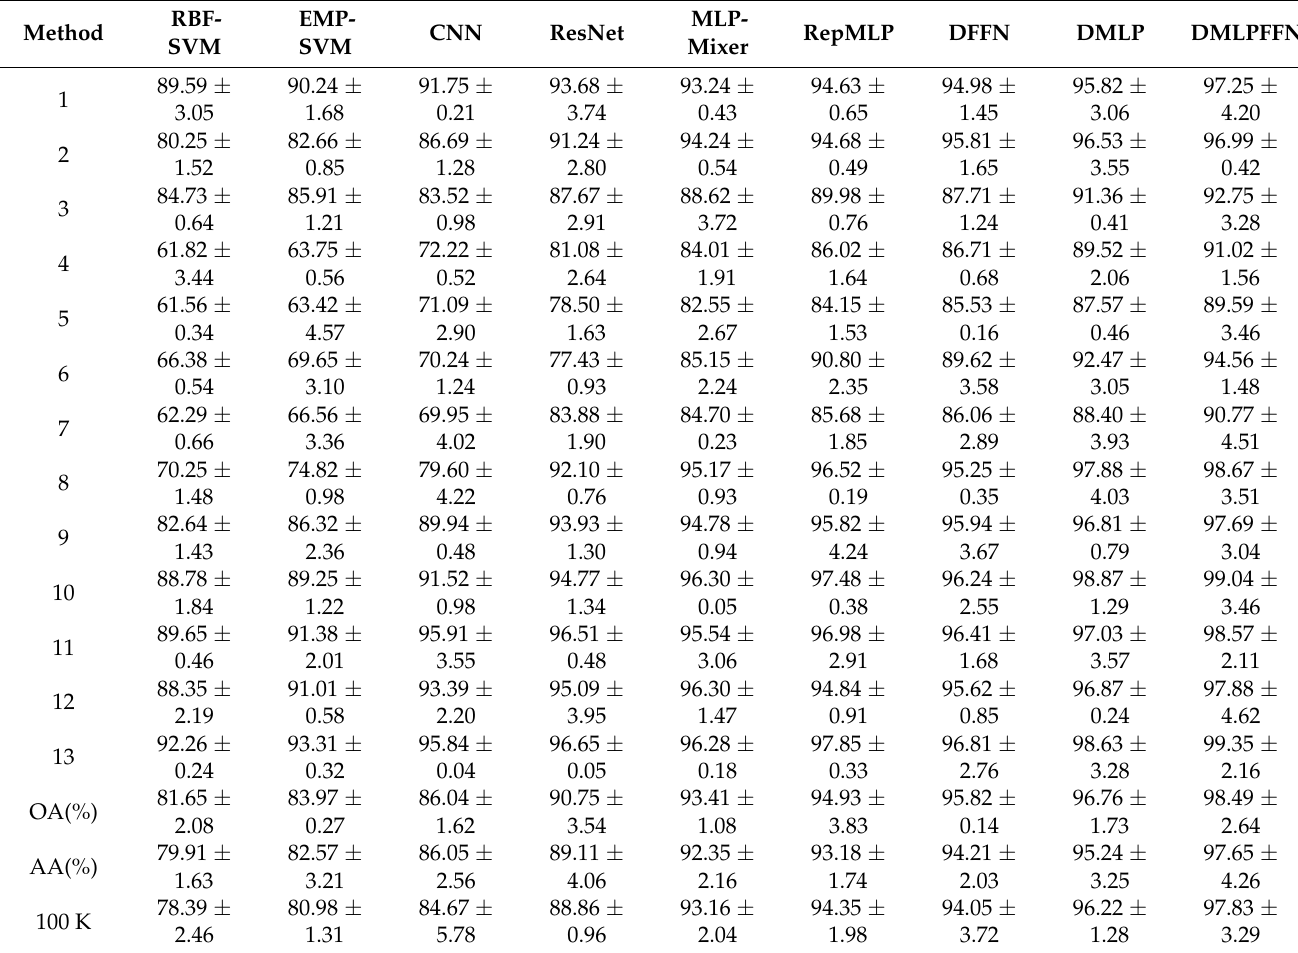
Table 5. Classification results on the KSC dataset by different classification